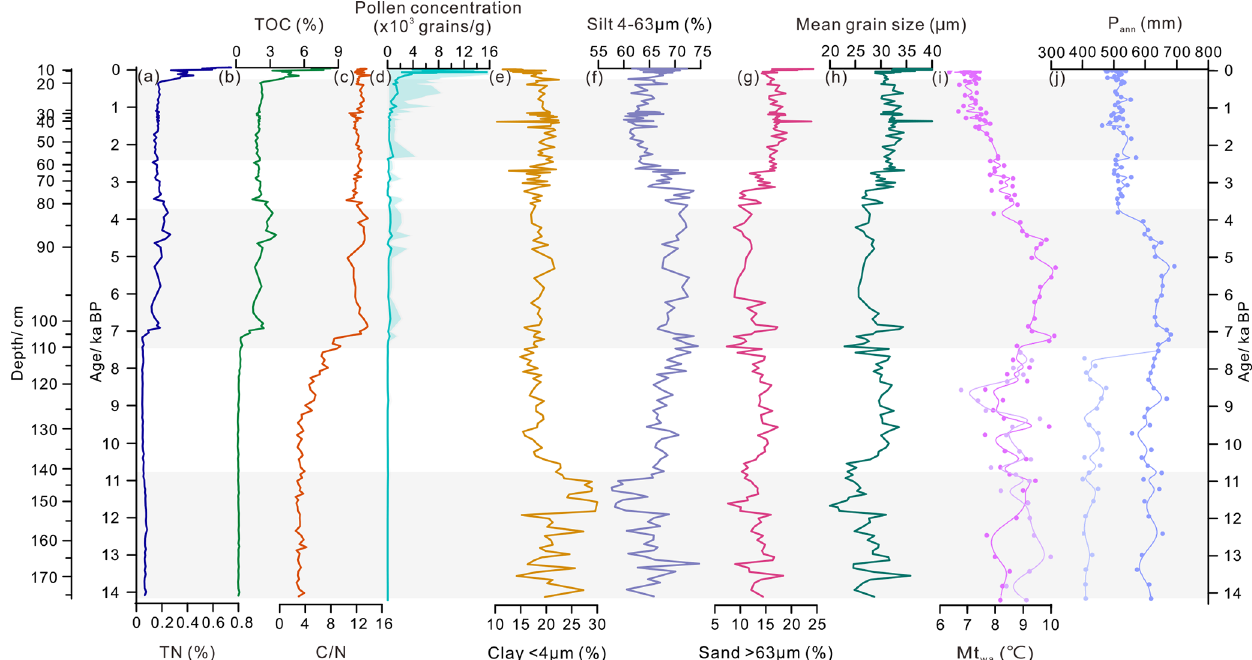
Figure 7. Comparison of the multiproxy records from Gahai Lake. (a) Total nitrogen (TN); (b) total organic carbon (TOC); (c) C / N ratio; (d) pollen concentration; (e–h) grain size distribution and mean grain size; (i) quantitative reconstruction of mean temperature of the warmest month (Mt wa ). The dark purple curve indicates the reconstruction based on the pollen assemblages including the arboreal pollen and the light purple curve represents the reconstruction based on the pollen assemblages removing the arboreal pollen (before 7.4ka only); (j) the quantitative reconstructions of mean annual precipitation ( P ann ). The dark blue curve is the reconstruction based on the pollen assemblages including the arboreal pollen, and the light blue curve is the reconstruction based on the pollen assemblages without the arboreal pollen (before 7.4ka only). The grey shading denotes the different pollen zones of Gahai